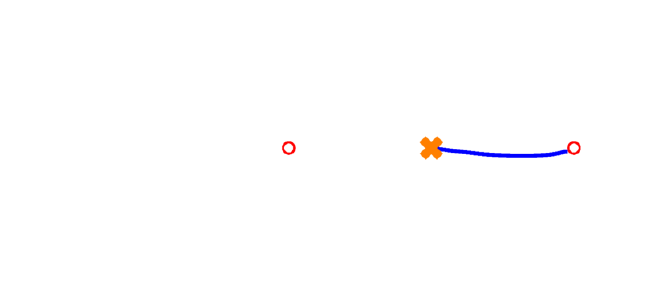
Figure 53. D4 brane at non-zero B-(cid:12)eld. Alice: How long is forever? White Rabbit: Sometimes, just one